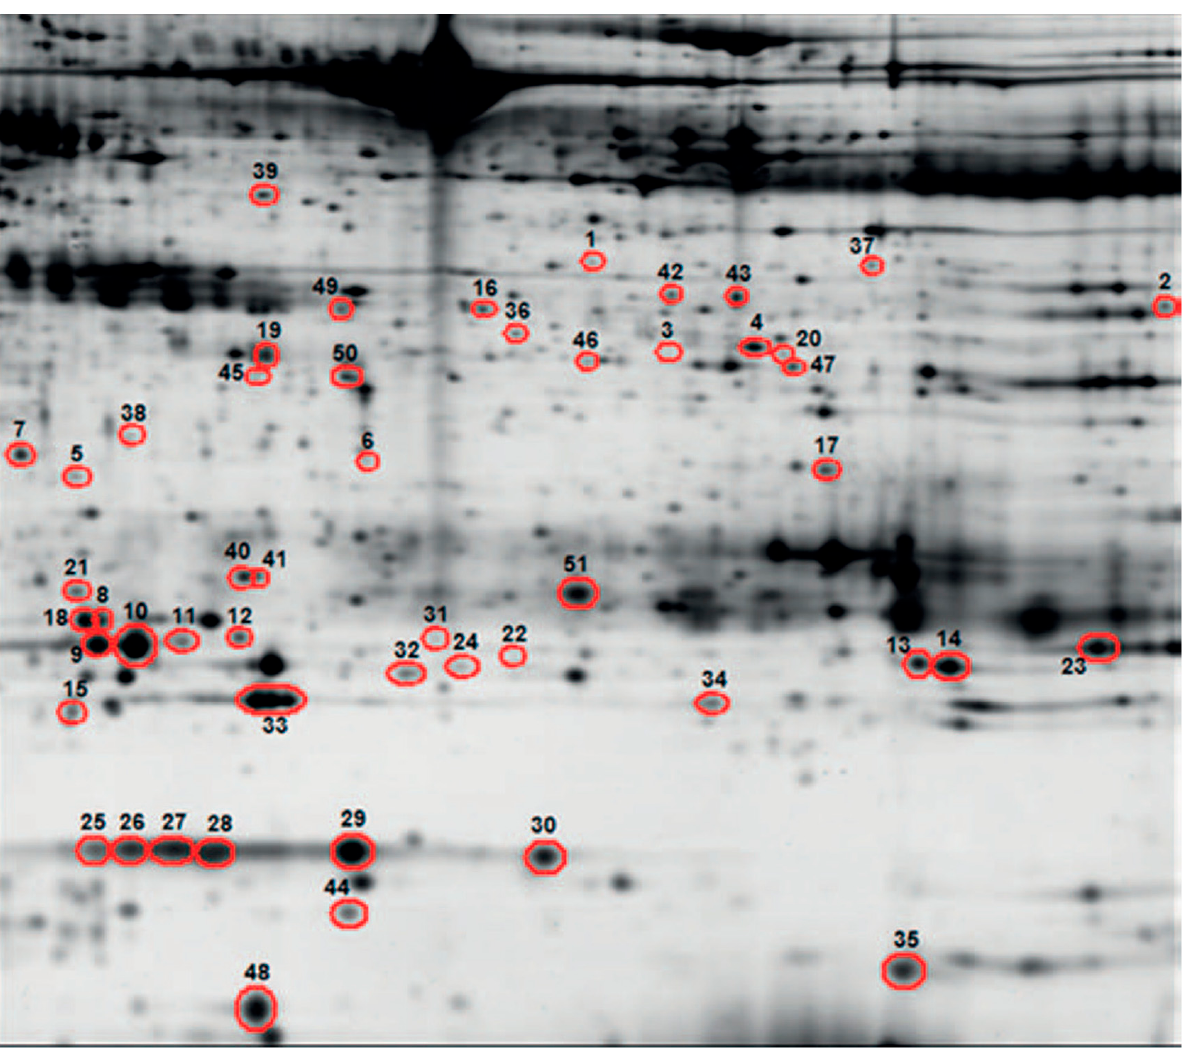
Figure 1. Example of a proteome from a bronchoalveolar lavage fluid sample in a lung cancer patient performed by two-dimensional gel electrophoresis and silver staining. Circled spots represent differ- entially expressed proteins between lung cancer and controls. Reprinted from [53] with permission from